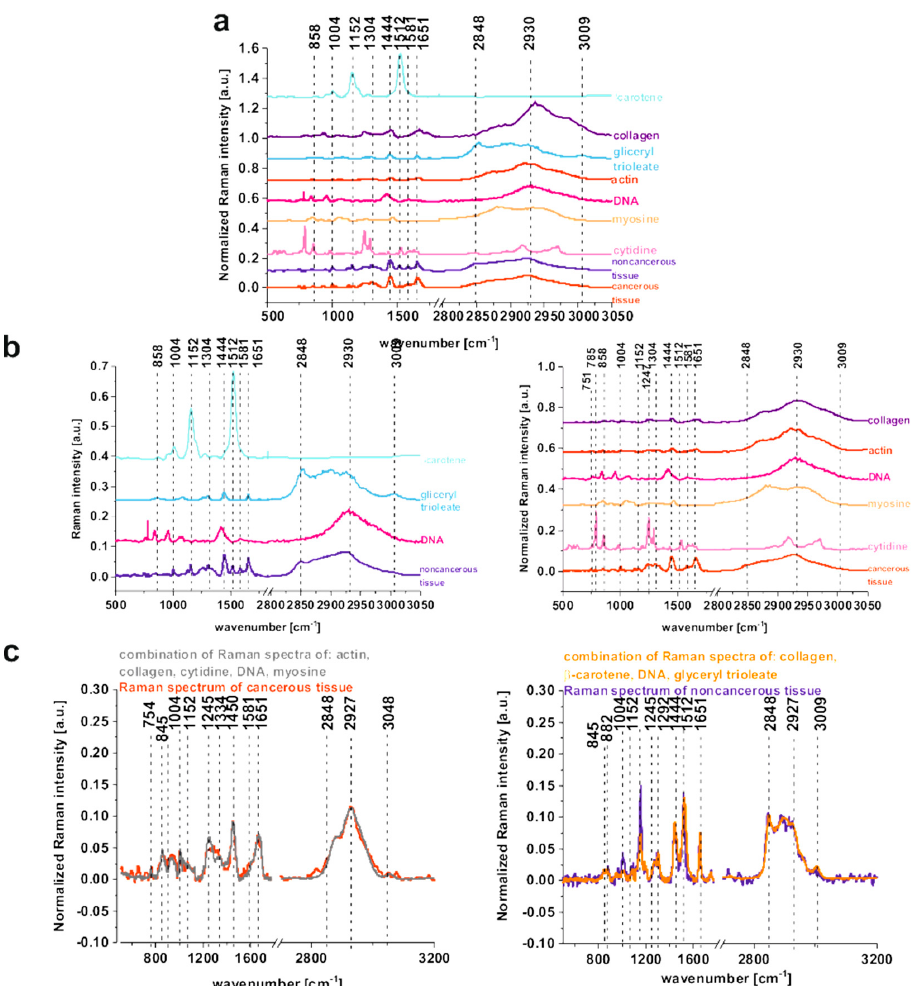
Figure 4. The comparison of the mean Raman spectra of the noncancerous and the cancerous tissues of the human colon (average spectra calculated based on 36,500 single spectra) and Raman spectra of DNA, lipids: glyceryl trioleate, proteins including structural proteins: collagen, actin, myosin, nucleoside molecule: cytidine, and natural antioxidants: beta-carotene ( a ), the comparison of the mean Raman spectra of the noncancerous human colon tissue with beta-carotene, glyceryl trioleate, DNA and the comparison of the mean Raman spectra of the cancerous human colon tissue with collagen, actin, DNA, myosin, cytidine ( b ) the comparison of the Raman spectra of the noncancerous and the cancerous human colon tissue with the combination of Raman spectra calculated based on pure components for the noncancerous and the cancerous human colon tissue (the combination of Raman spectra of pure components was performed using WITec Project Plus) ( c